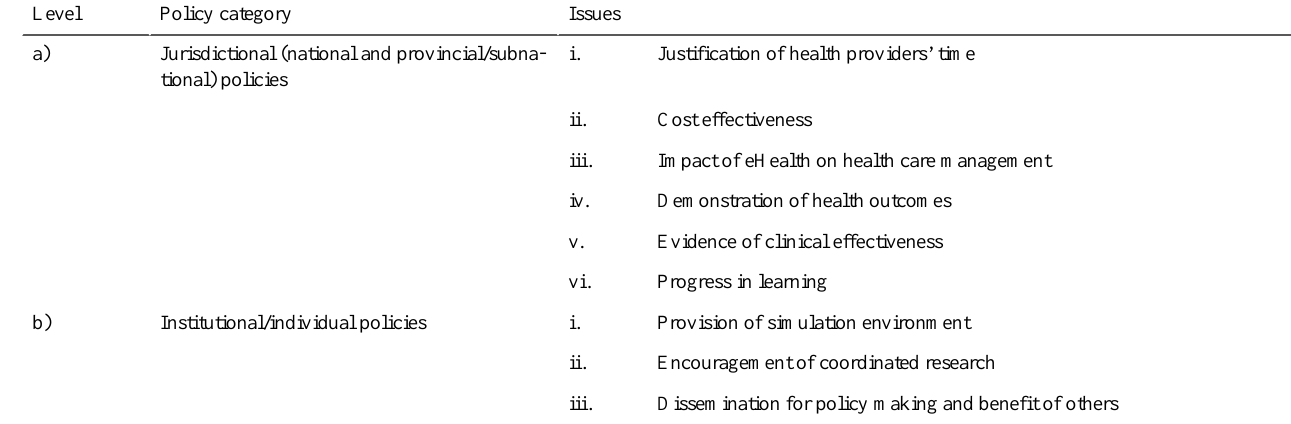
Table 7. Evaluation and research.